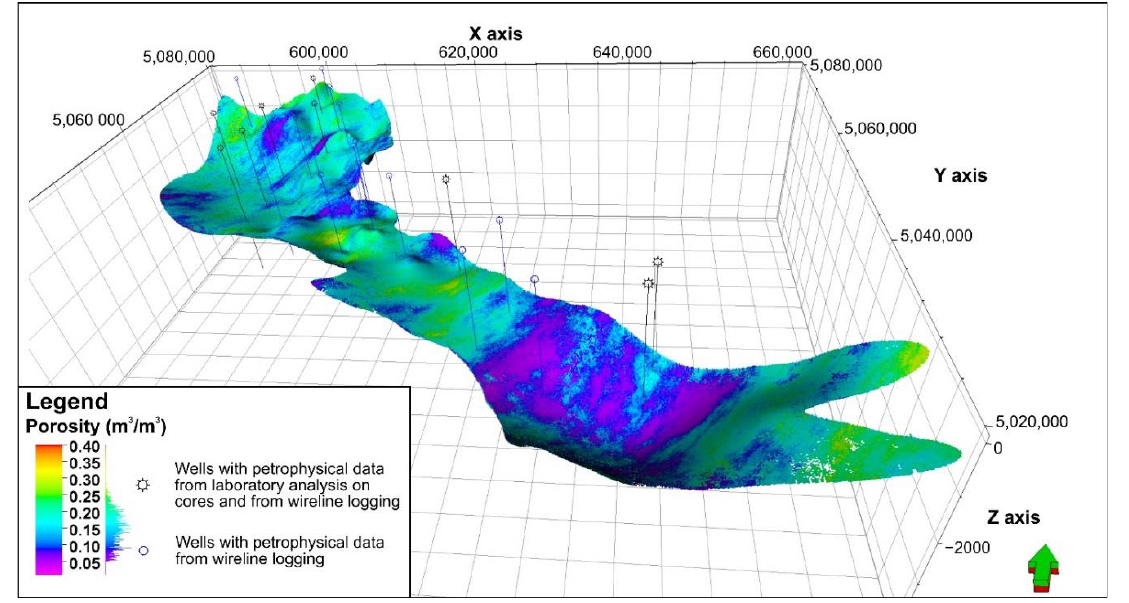
Figure 6. Spatial distribution of the porosity within the DSA Poljana with a frequency plot.